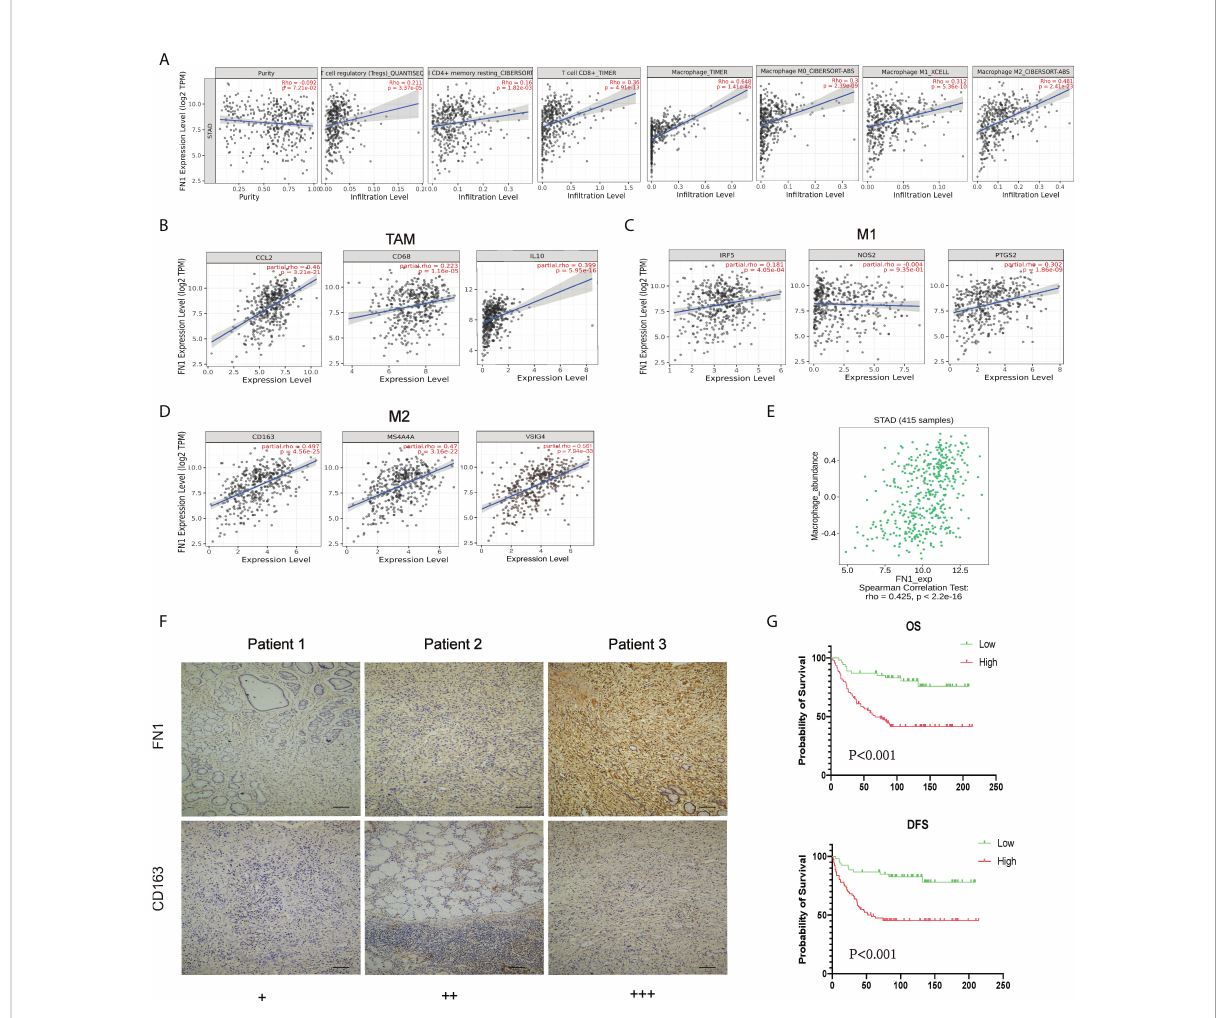
FIGURE 7 Correlation analysis between FN1 and related genes and markers of macrophages. (A) FN1 expression is negatively related to tumor purity and has signi fi cant positive correlations with in fi ltrating levels of Tregs, CD4+ T cells, CD8+ T cells, and macrophages in STAD. (B – D) Scatterplots of correlations between FN1 expression and gene markers of macrophages, TAMs (B) , and M1 (C) and M2 macrophages (D) in STAD. (E) Correlation between FN1 expression and Macrophage in gastric cancer available at the TISIDB database. Color images are available online (n = 415). (F) Correlation between FN1 expression and CD163 in gastric cancer. Gastric cancer tissue was quantitated by scoring staining intensity, including negative ( – ) and weak (+) staining, moderate (++) and strong (+ + +) staining, respectively. Scale bar = 100 m m. (G) OS and DFS analysis of FN1 in